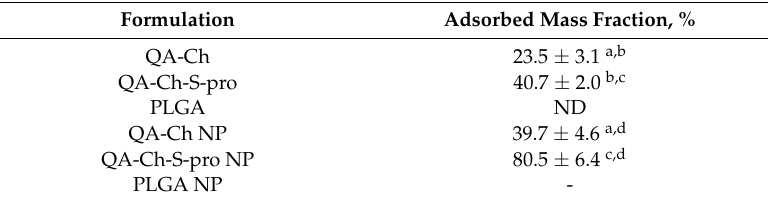
QA-Ch = quaternary ammonium chitosan; QA-Ch-S-pro = quaternary ammonium S-protected thiolated chitosan; PLGA = poly(lactic- co -glycolic acid); ND = not determined. a,b,c,d , significantly different from each